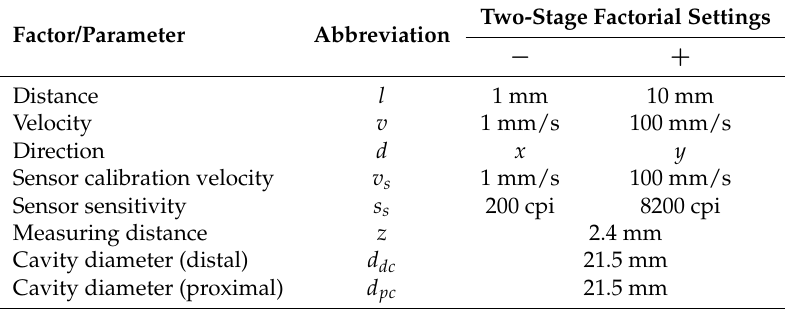
Table 1. Values of two-stage fractional factorial screening test factors and parameters for trial session